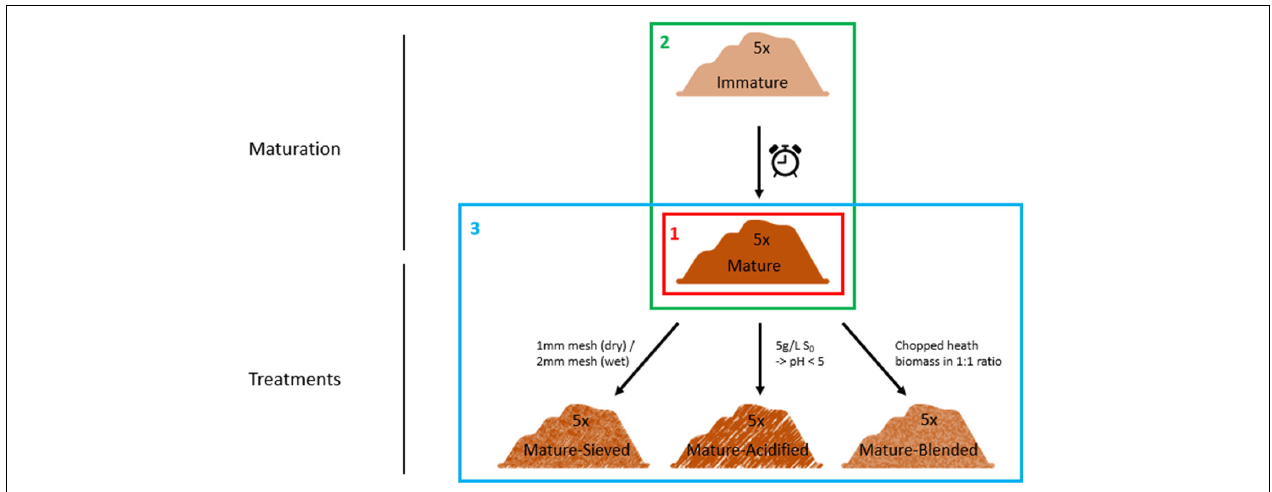
FIGURE 1 | Set-up of the experiment. Five immature composts were matured by further storage. The matured composts were subsequently sieved or acidified by addition of elemental sulfur or blended with chopped heath biomass. These composts were characterized for their microbiological characteristics using three techniques: metabarcoding, PLFA analysis and Biolog EcoPlates. First, we determined the main microbiological differences between the 5 mature composts (Frame 1; see “Main Microbiological Differences Between the Five Mature Composts and the Effect of Compost Batch”) and the effect of compost batch. Second, the effect of compost maturation was evaluated, by comparing the microbiome of immature and mature composts in each compost batch (Frame 2; see “Effect of Compost Maturation”). Third, the effect of blending, sieving, and acidification on the microbiome was studied in each compost batch, for which the mature composts were used as a reference [Frame 3; see “Treatment Effects (Blending, Sieving and